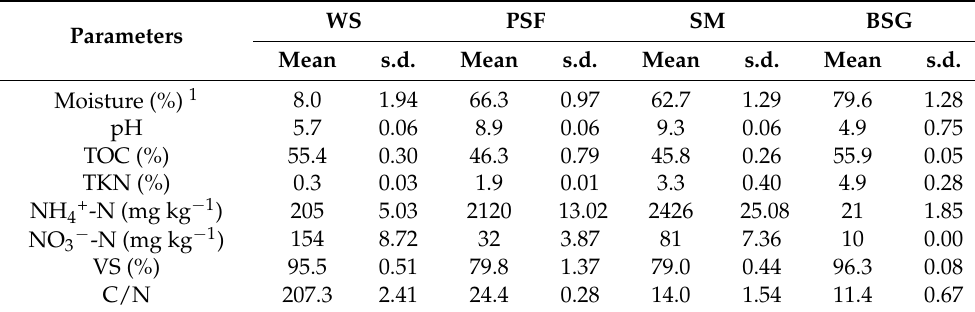
Table 1. Physicochemical characteristics (mean value and standard deviation of three replicates) of the organic materials involved in the experiment: Wheat Straw—WS; Pig Solid Fraction—PSF; Sheep Manure—-SM; brewers’ spent grain—BSG. (Dry weight basis).